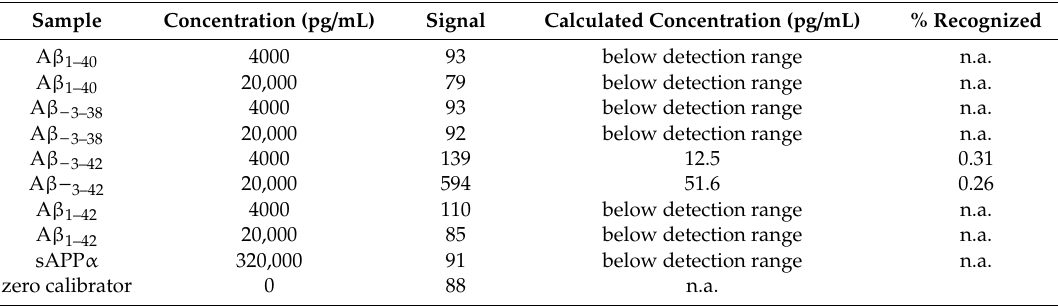
Table 1. Cross reactivity of the A β − 3–40 immunoassay.